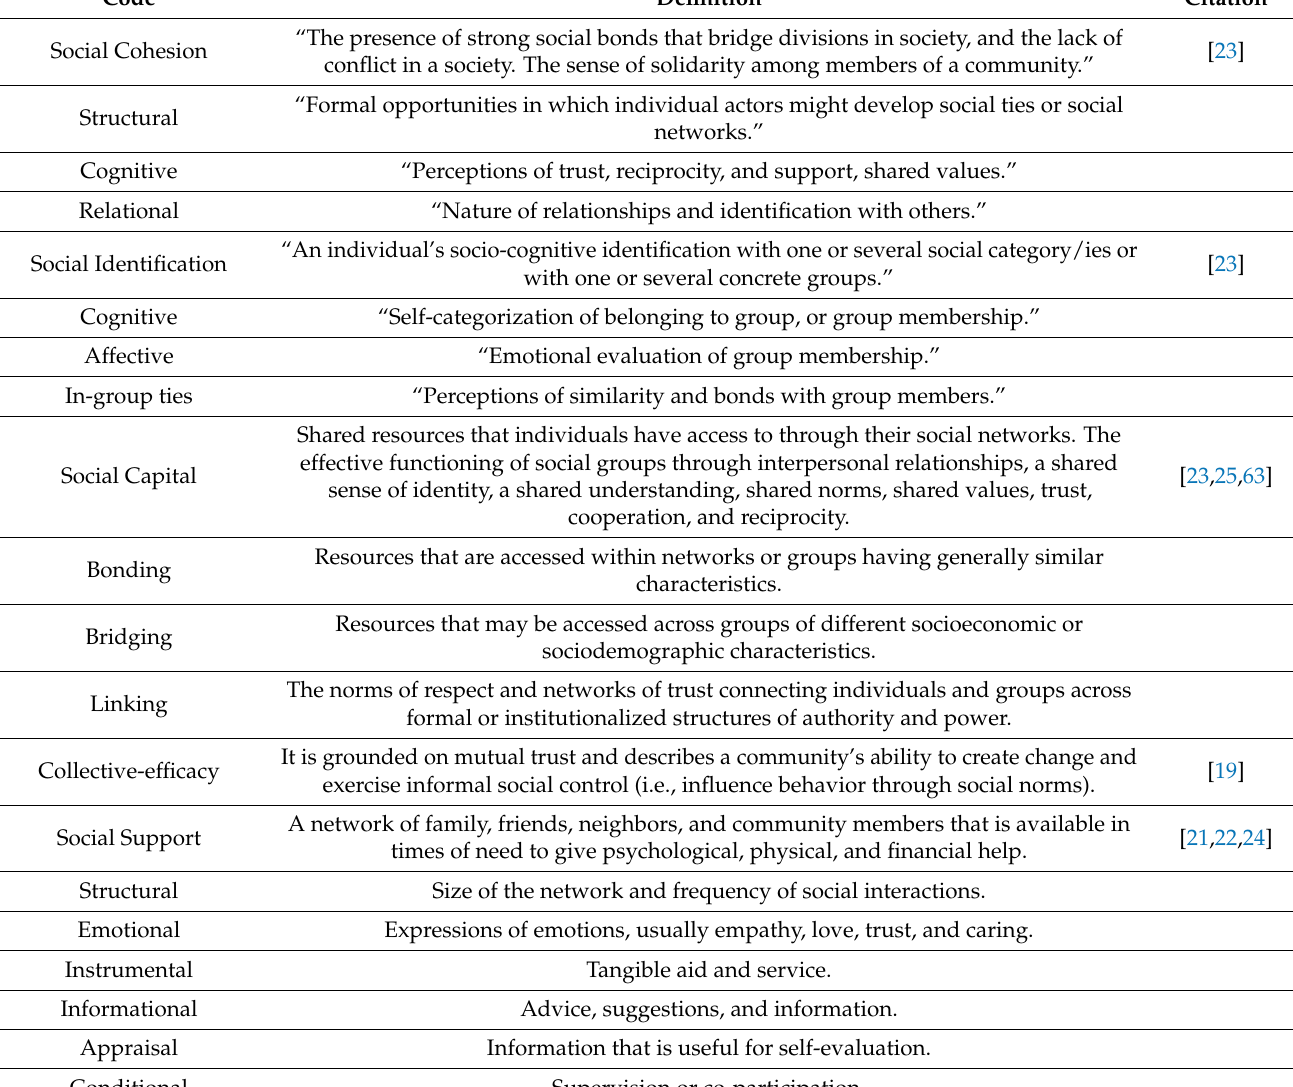
Table 1. Coding frame categories, subcategories, and